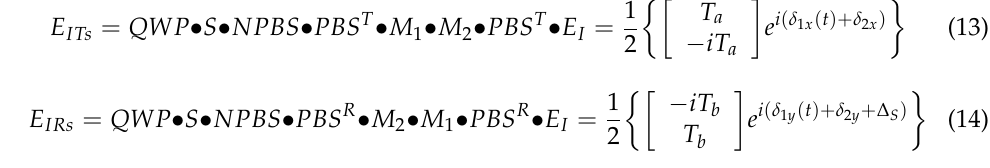
Figure 3. Schematic of the proposed modified Sagnac interferometer with the presence of samples.